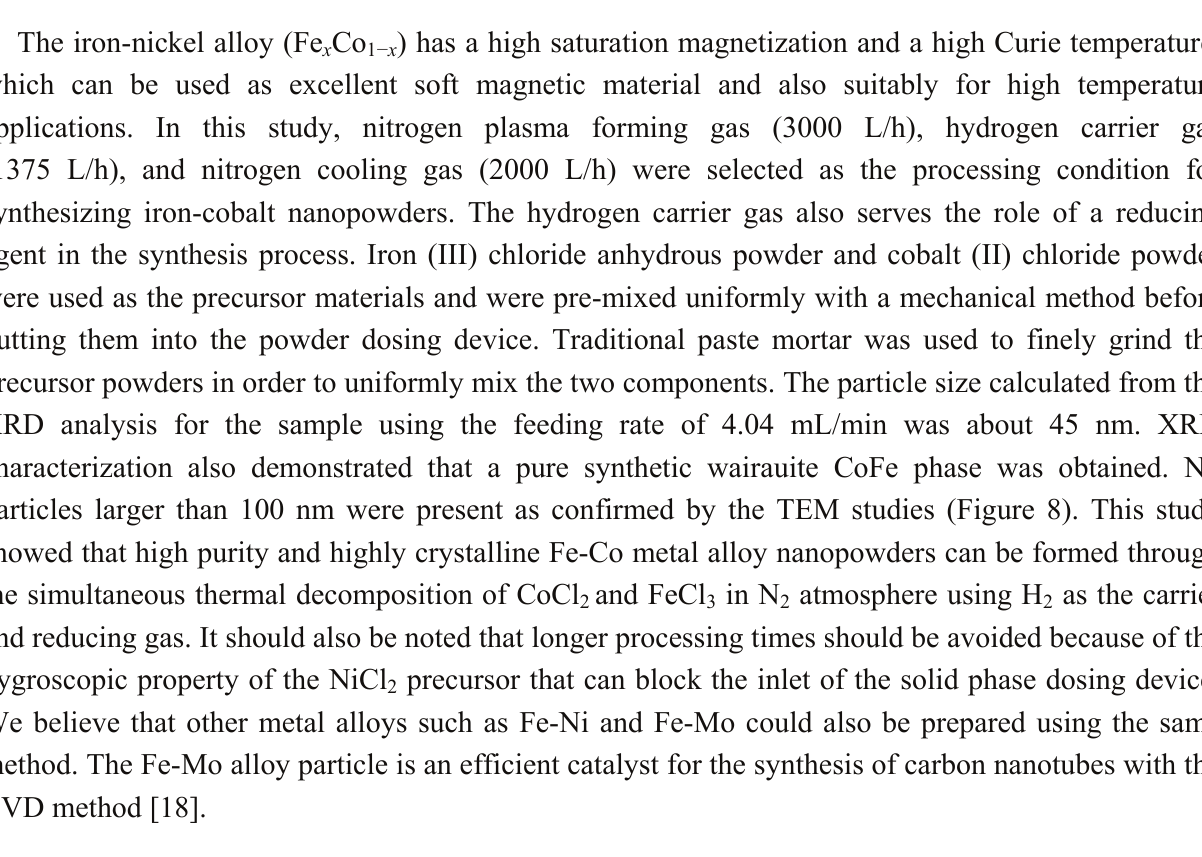
Figure 8. ( a ) Transmission electron micrograph of Iron-Cobalt nanopowders; ( b ) X-ray diffraction pattern of Iron-Cobalt nanopowders.